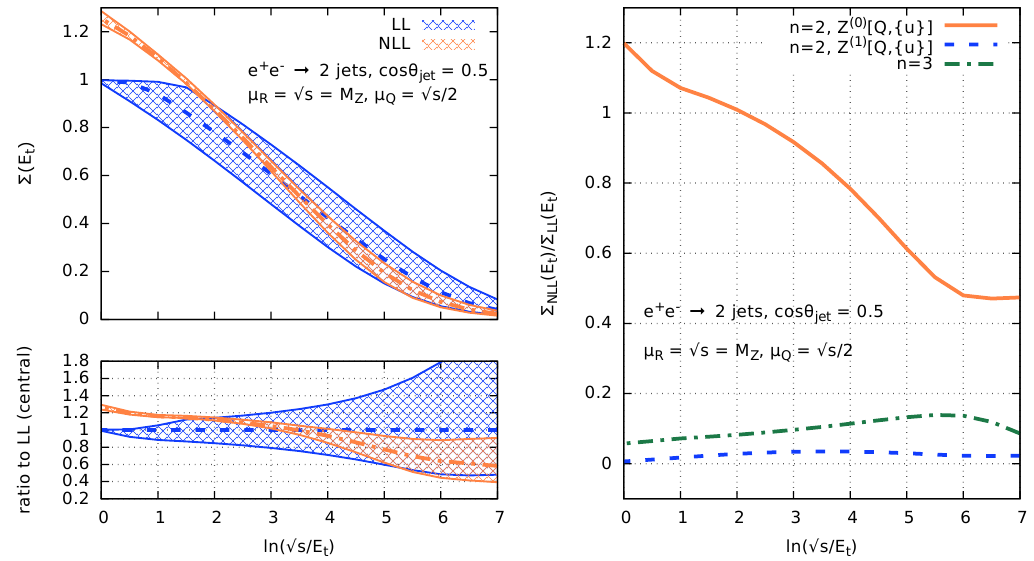
Figure 4 . Left: cumulative distribution Σ( E t ) for the transverse energy in the interjet rapidity gap at LL and NLL for c = 0 . 5 . Right: breakdown of the contributions to the NLL correction, relative to the LL